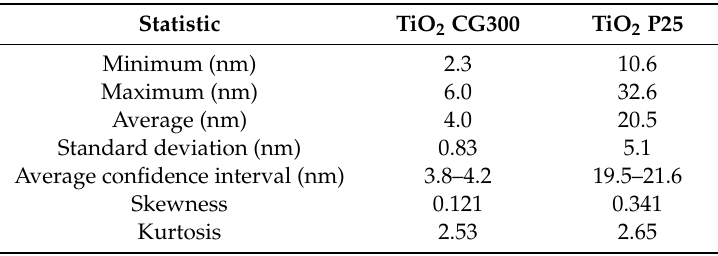
Table 1. Basic statistics of TiO 2 nanoparticles.